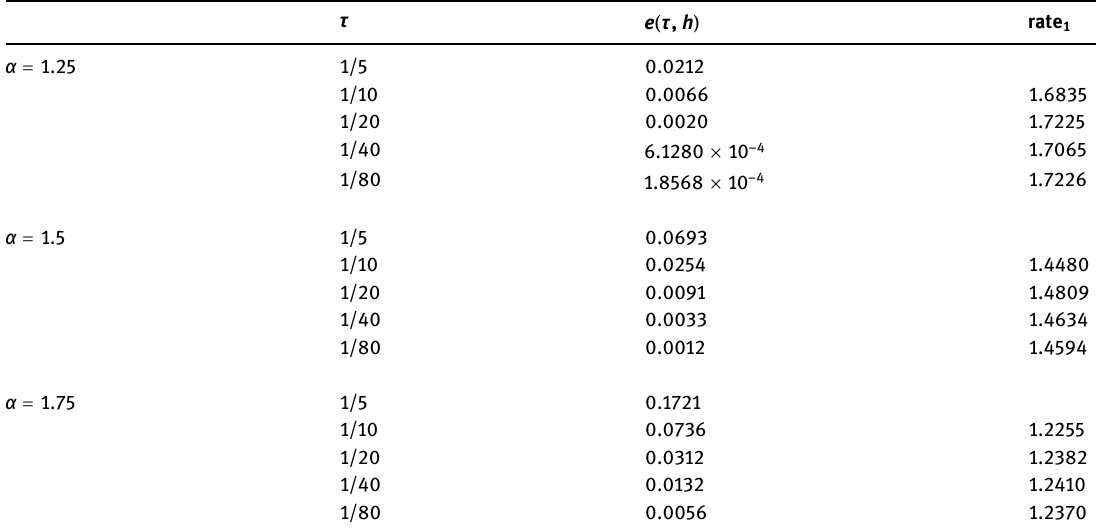
Table 1: Maximum norm errors and temporal convergence orders of the proposed scheme when = / h π 16 for Example 1 τ ( ) e τ h , rate 1 = α 1.25